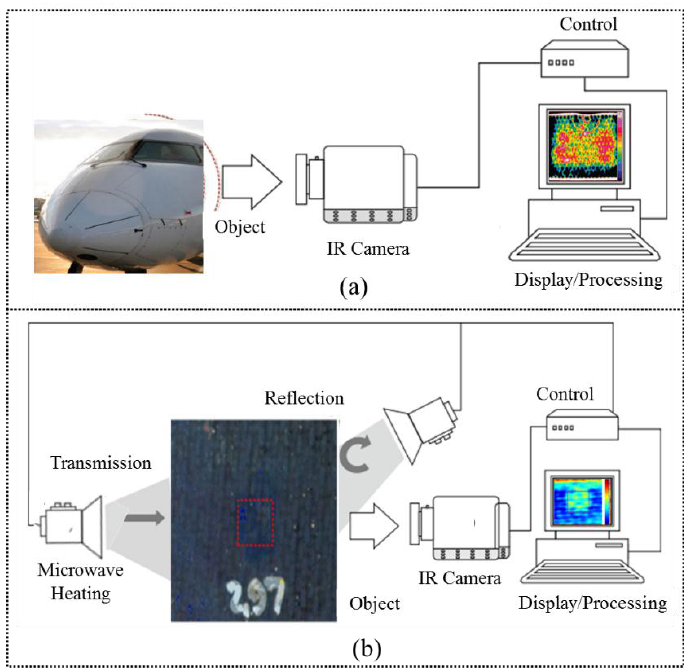
Figure 1. MWT setup for ( a ) the passive approach and ( b ) the active approach.